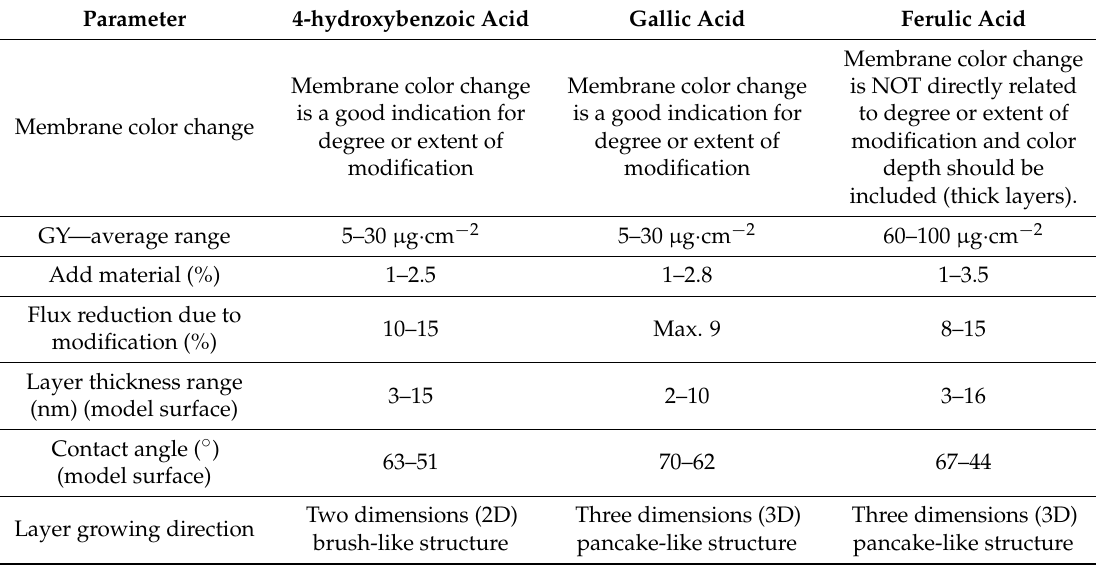
Table 3. Comparison between the three modifiers: 4-hydroxybenzoic acid, gallic acid, and ferulic acid